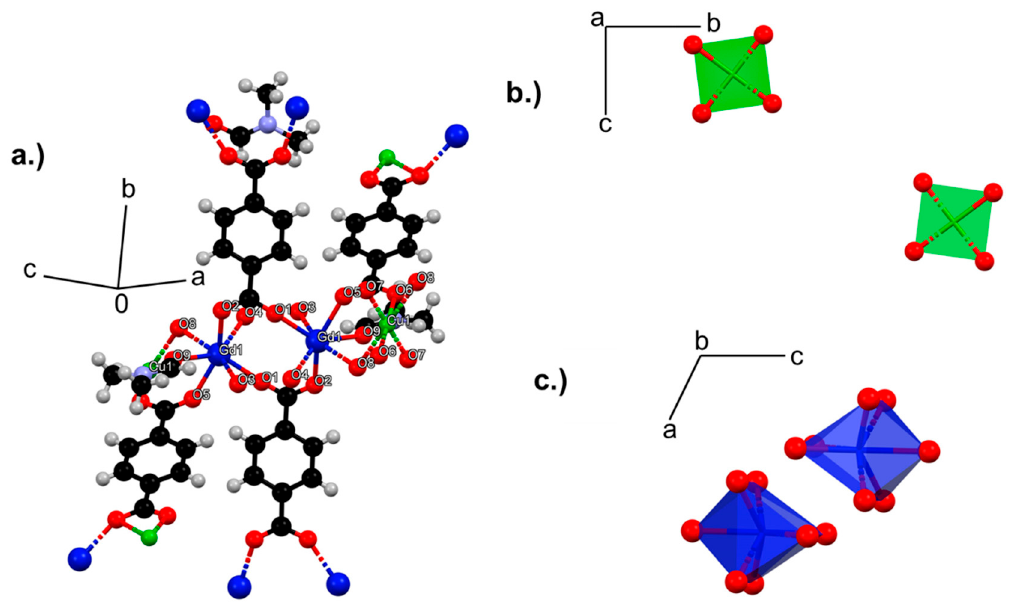
Figure 1. The colors for elements are as follows: gadolinium (blue), copper (green) oxygen (red), carbon (black), nitrogen (purple), hydrogen (white). ( a ) View of basic unit cell of Compound 1 . ( b ) Coordination environment of a square planar copper. ( c ) Coordination environment of the lanthanide ions showing a trigonal prismatic coordination.